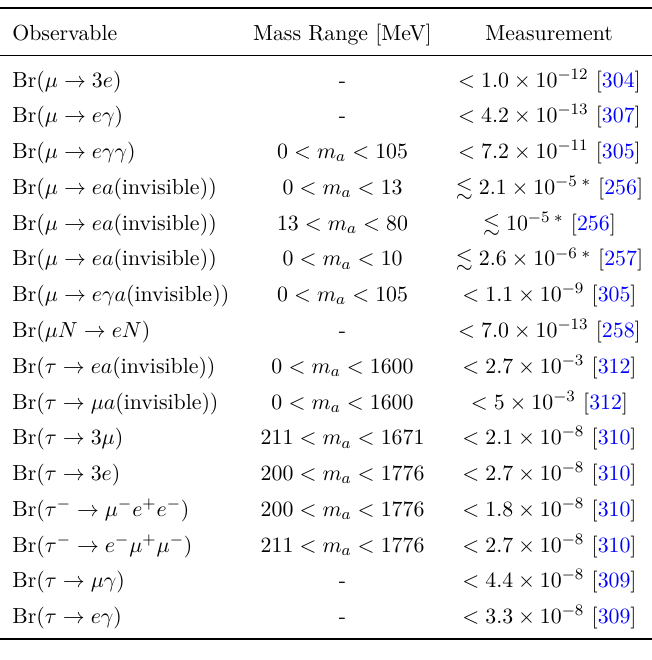
Table 9 . Lepton flavor-violating observables. Where a mass range for m a is given, the range refers to masses that are consistent with the experimental cuts and for which the decay can proceed via a resonant ALP. For some of the observables (for example µ → 3 e ), an ALP lying outside of this mass range may still be constrained by the experiment, if it can mediate the decay off-shell. Where the mass range is left blank, the measurement can never involve a resonant ALP. ∗ : for the µ → ea ( invisible ) searches, the precise bound depends on the chirality of the ALP couplings due to the experimental setup, see [69, 256, 257] for details.